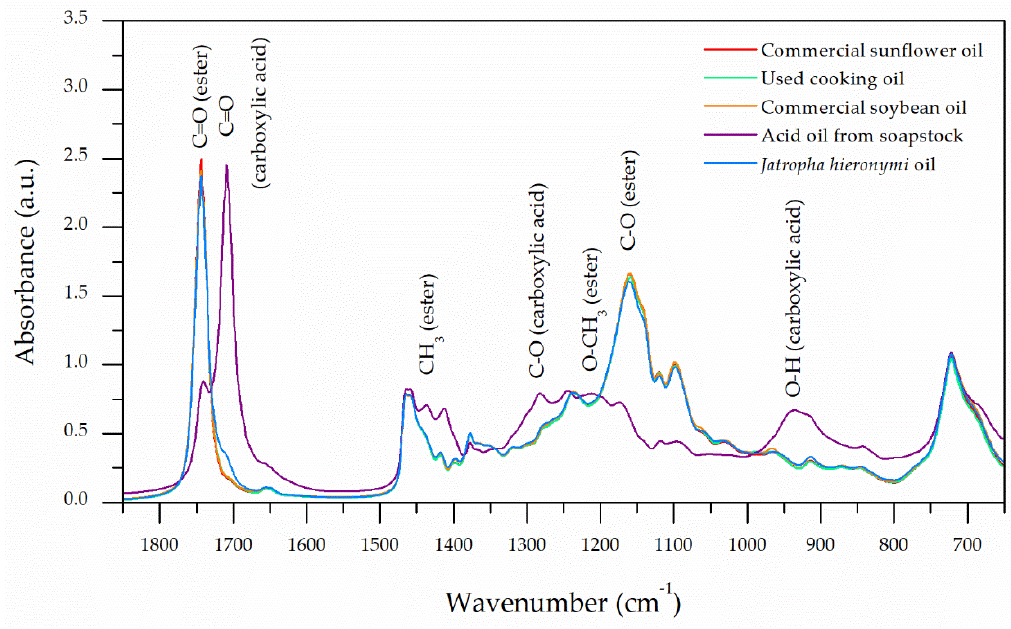
Figure 2. FT-IR spectra of the evaluated feedstocks.